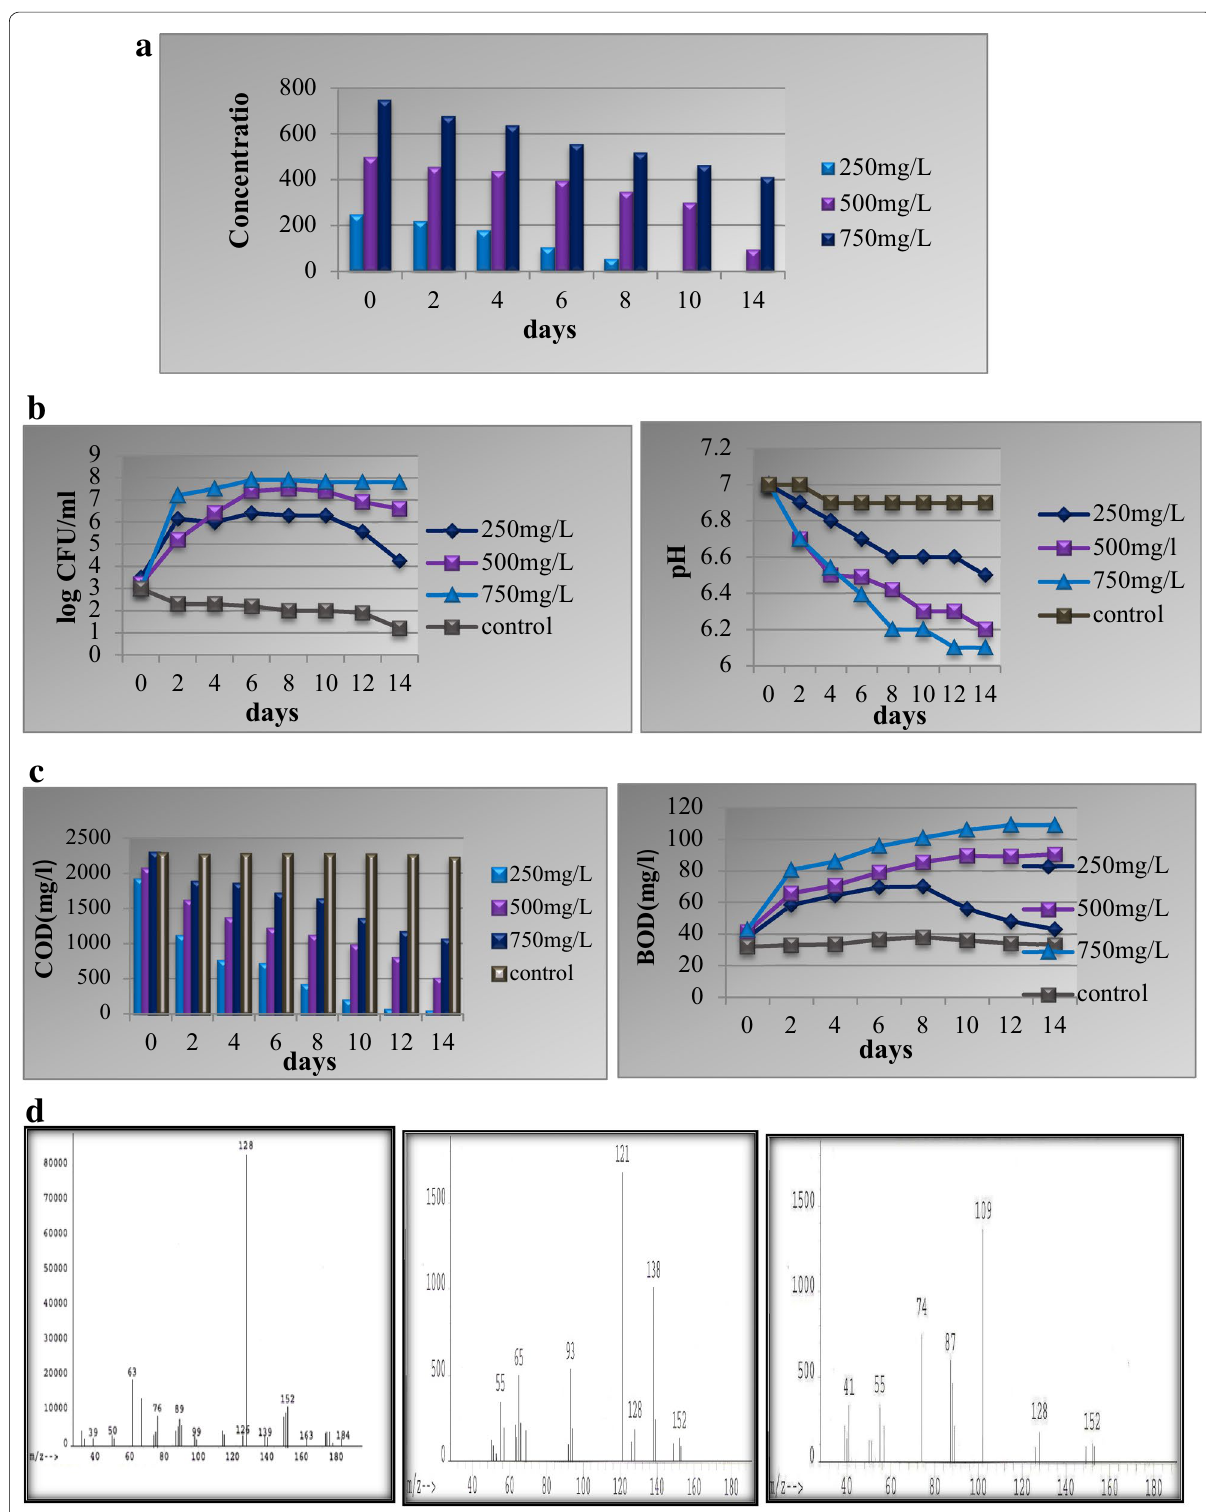
Fig. 3 a Degradation of naphthalene by Pseudomonas aeruginosa in TMM. b Variations in viable count and pH during bioremediation of naph- thalene by P. aeruginosa in TMM. c Variations in COD and BOD during bioremediation of naphthalene by P. aeruginosa in TMM. d Mass spectra of naphthalene ( m/z identification 128), salicyliate ( m/z identification 138), and catechol ( m/z identification